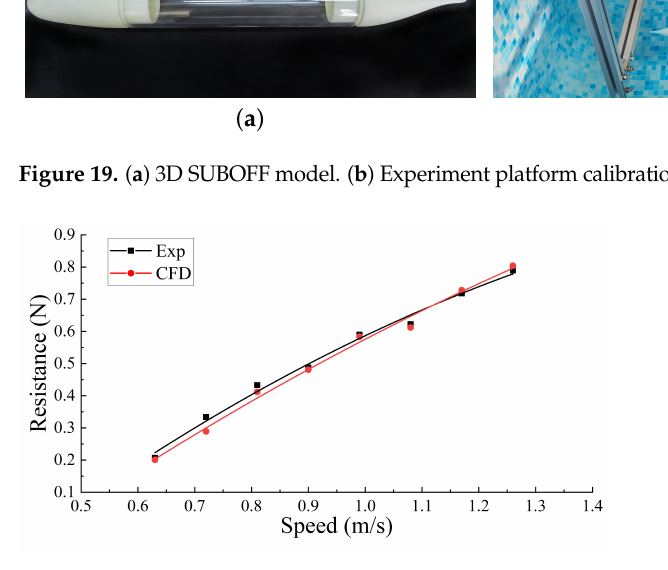
Figure 20. Comparison between physical experimental results and numerical results of hydrodynamic coefficient estimation of the 1/8 SUBOFF model.